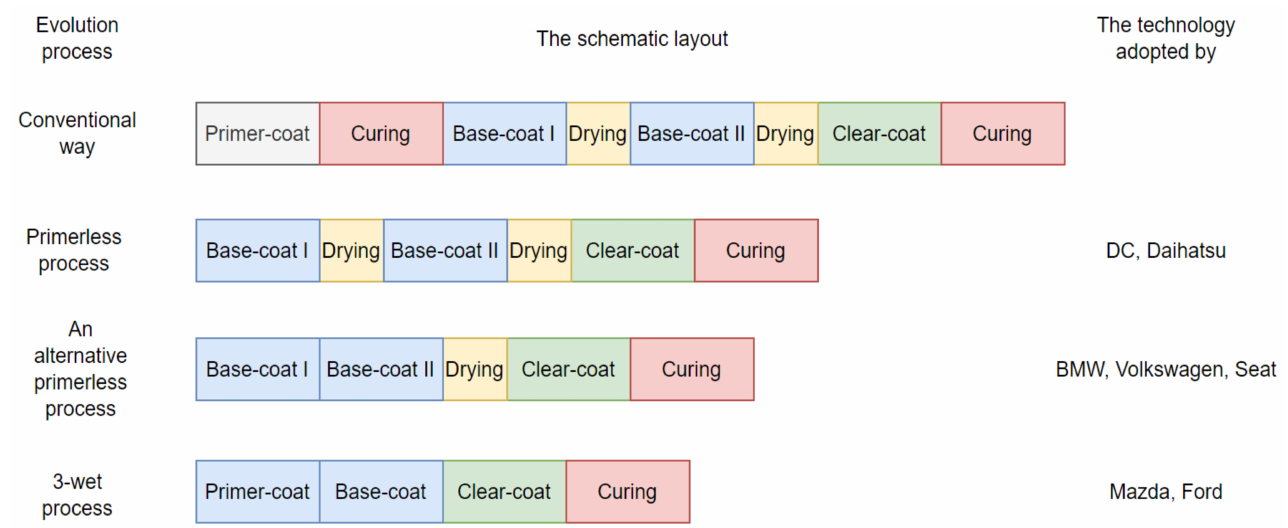
Figure 3. The evolution of the painting process, adapted from